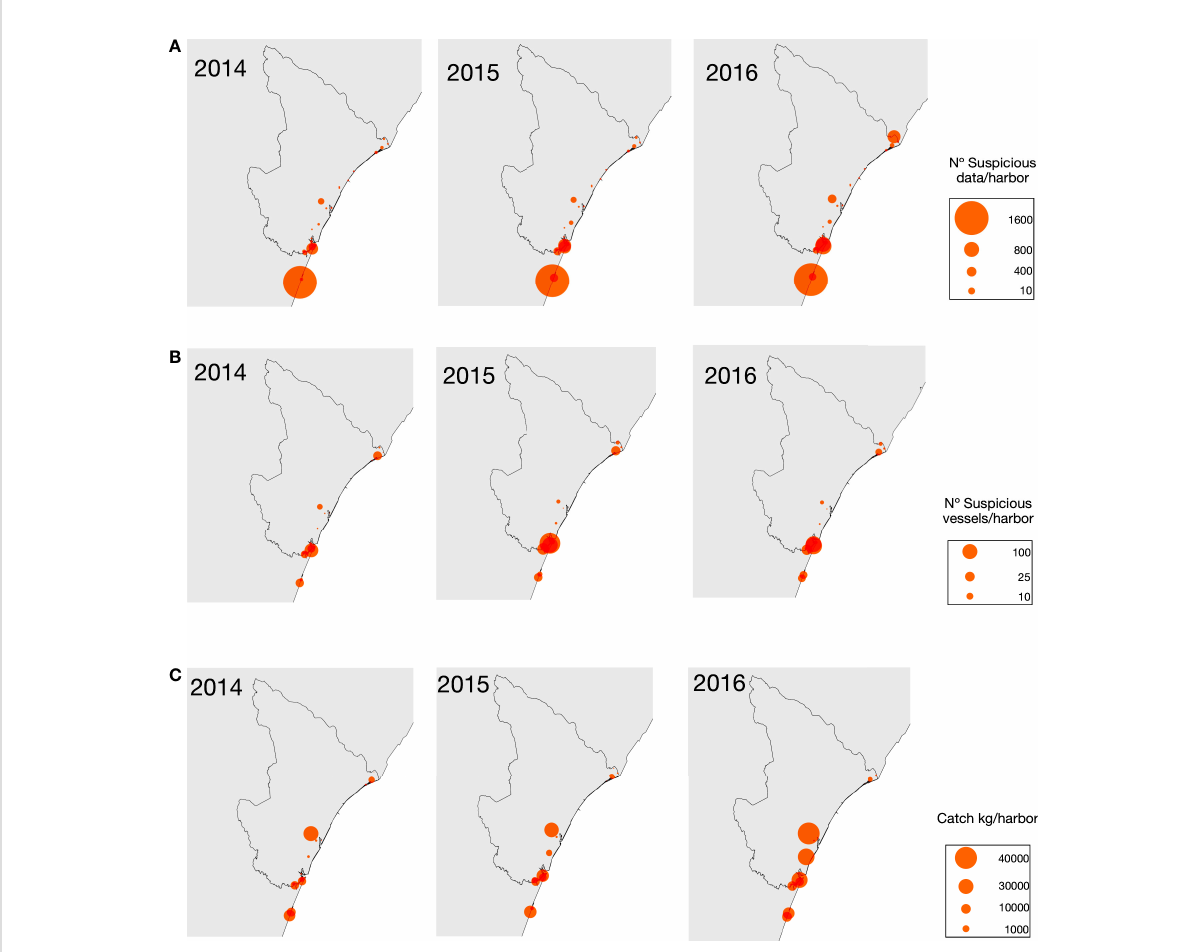
FIGURE 6 Scatter map of suspicious data of non-motorized canoes (A) , suspicious vessels (B) , and total catch (C) for each harbor in 3 years of the study. Circle size is related to the magnitude of the number of suspect data, suspect vessels, and catch size